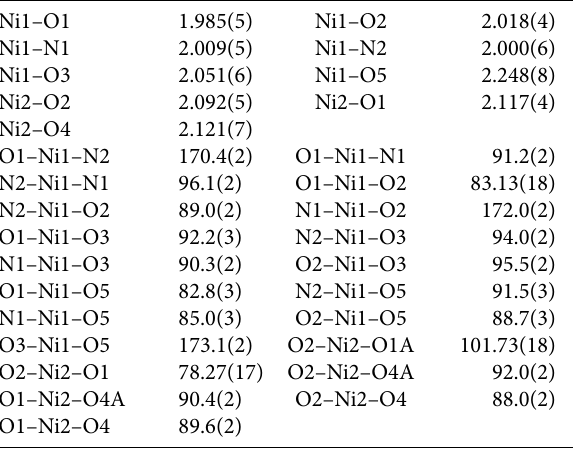
Table 2. Selected bond lengths (Å) and angles (°) for the complexes with estimated standard deviations (e.s.d.s) in